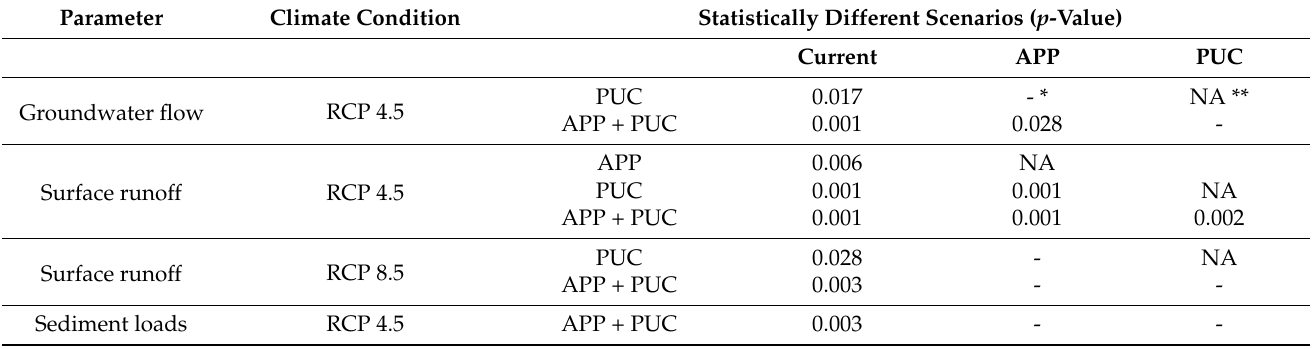
Table 7. Statistically different annual mean parameter values between different land use land cover (LULC) change scenarios for each climate condition, according to the Kolmogorov–Smirnov